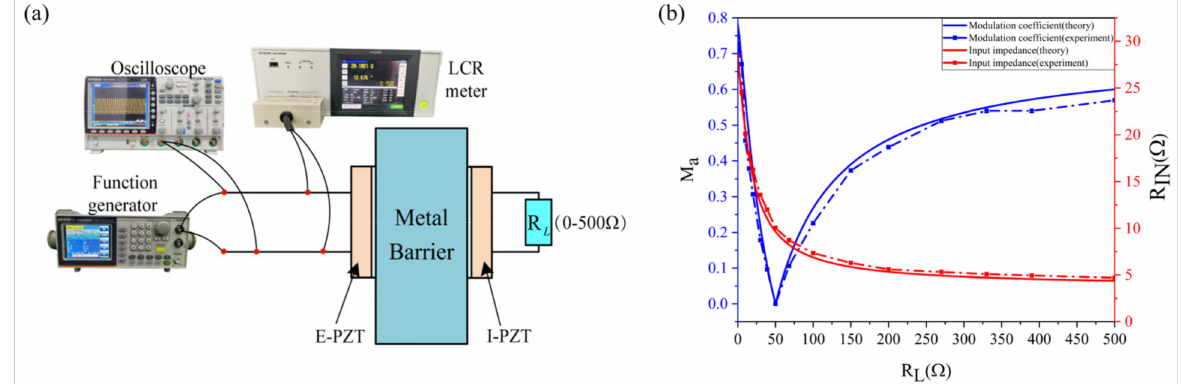
Figure 7. Verification of the Channel Model. ( a ) Measurement configuration for verifying the channel circuit model. ( b ) Comparison of experimental and theoretical values of input impedance and modulation coefficient before